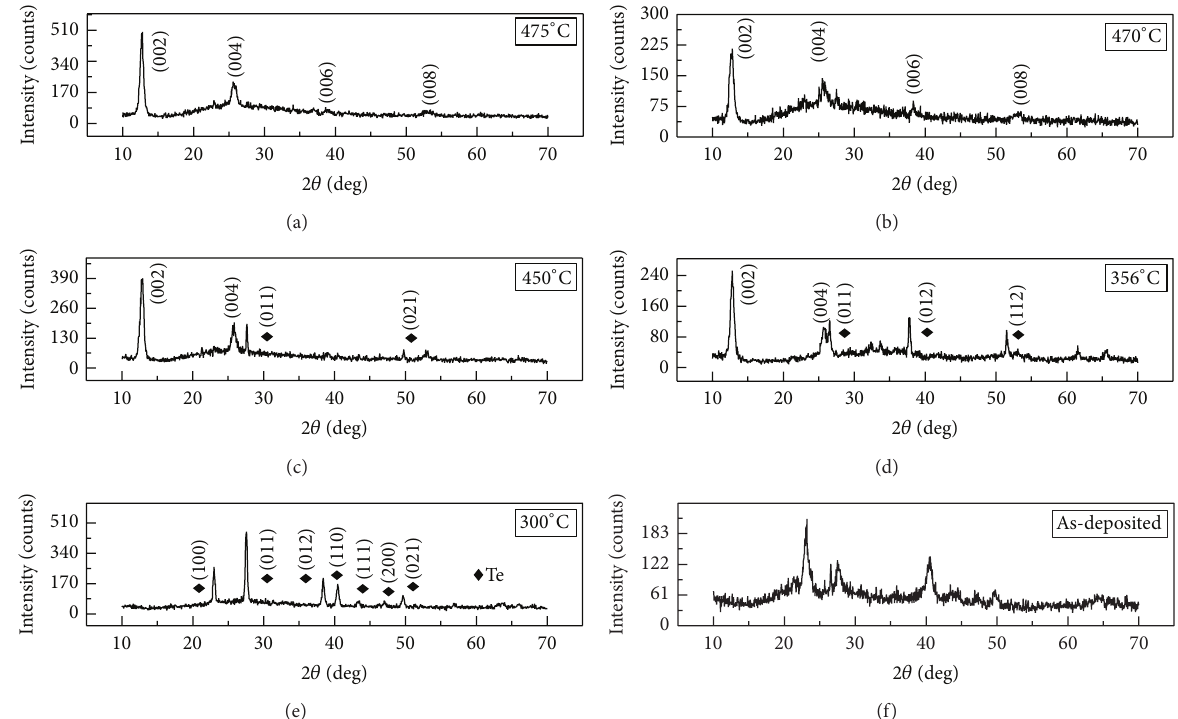
Figure 1: XRD patterns of Mo-Te thin films annealed at different temperatures for 15 min in N 2